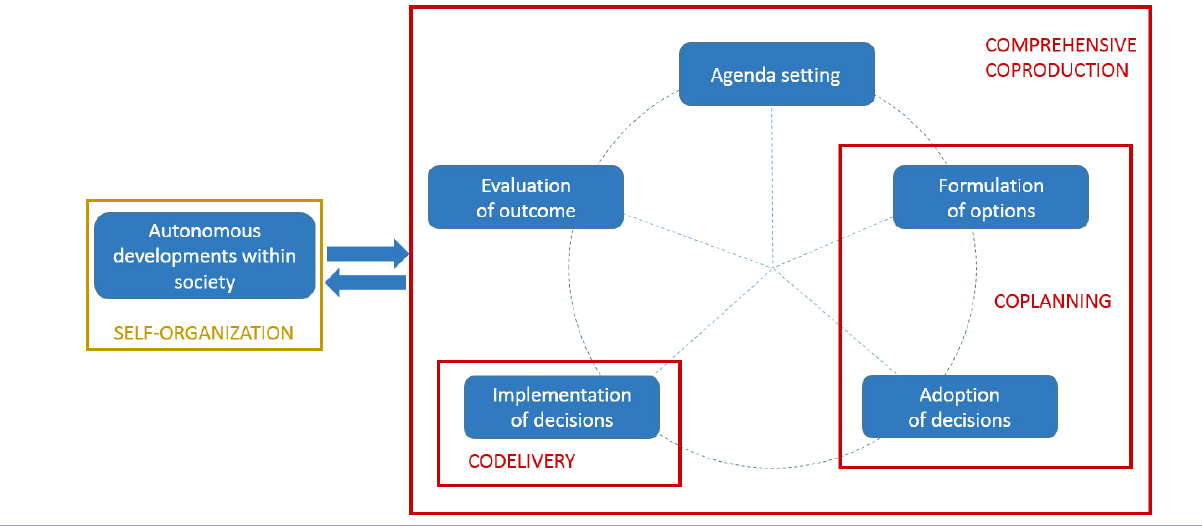
Fig. 1 . Forms of coproduction. This figure has been developed by Barbara Tempels and Hannelore Mees (adapted from Mees et al. 2016 b ). It is based on the phases of the policy cycle and acknowledges the existence of coevolution between these phases and autonomous